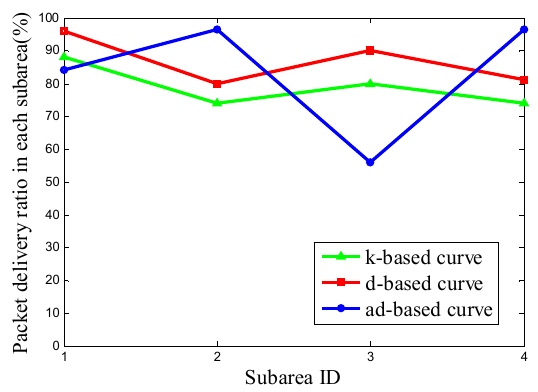
Figure 19. The PDR of k-based, d-based and adjustable d-based curve in node deployment (b): C 1 , C 3 are deployed with 50 nodes and C 2 , C 4 are deployed with 350 nodes.